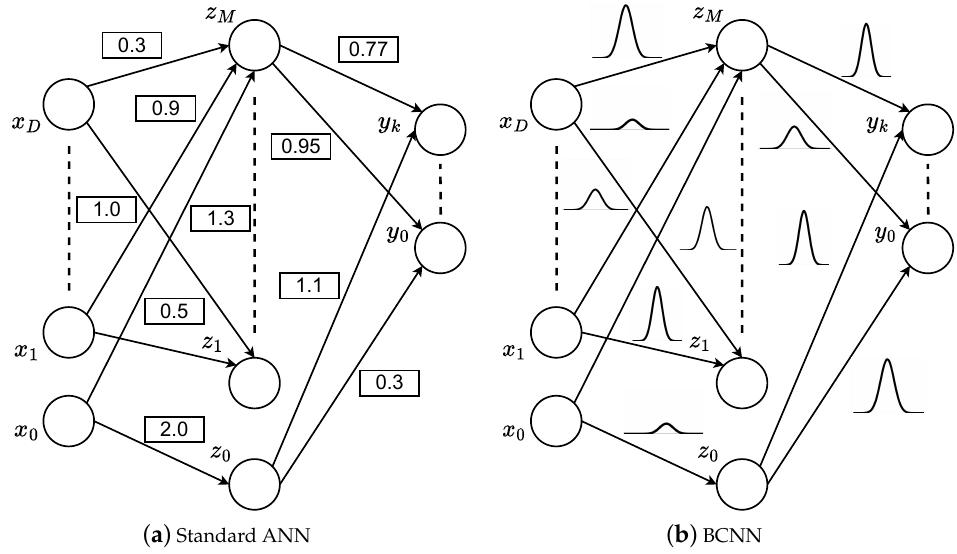
Figure 3. Side by side comparison of the structures of a standard ANN and a BCNN. The weights of the ANN are represented by discrete values, whereas the BCNN makes use of probability